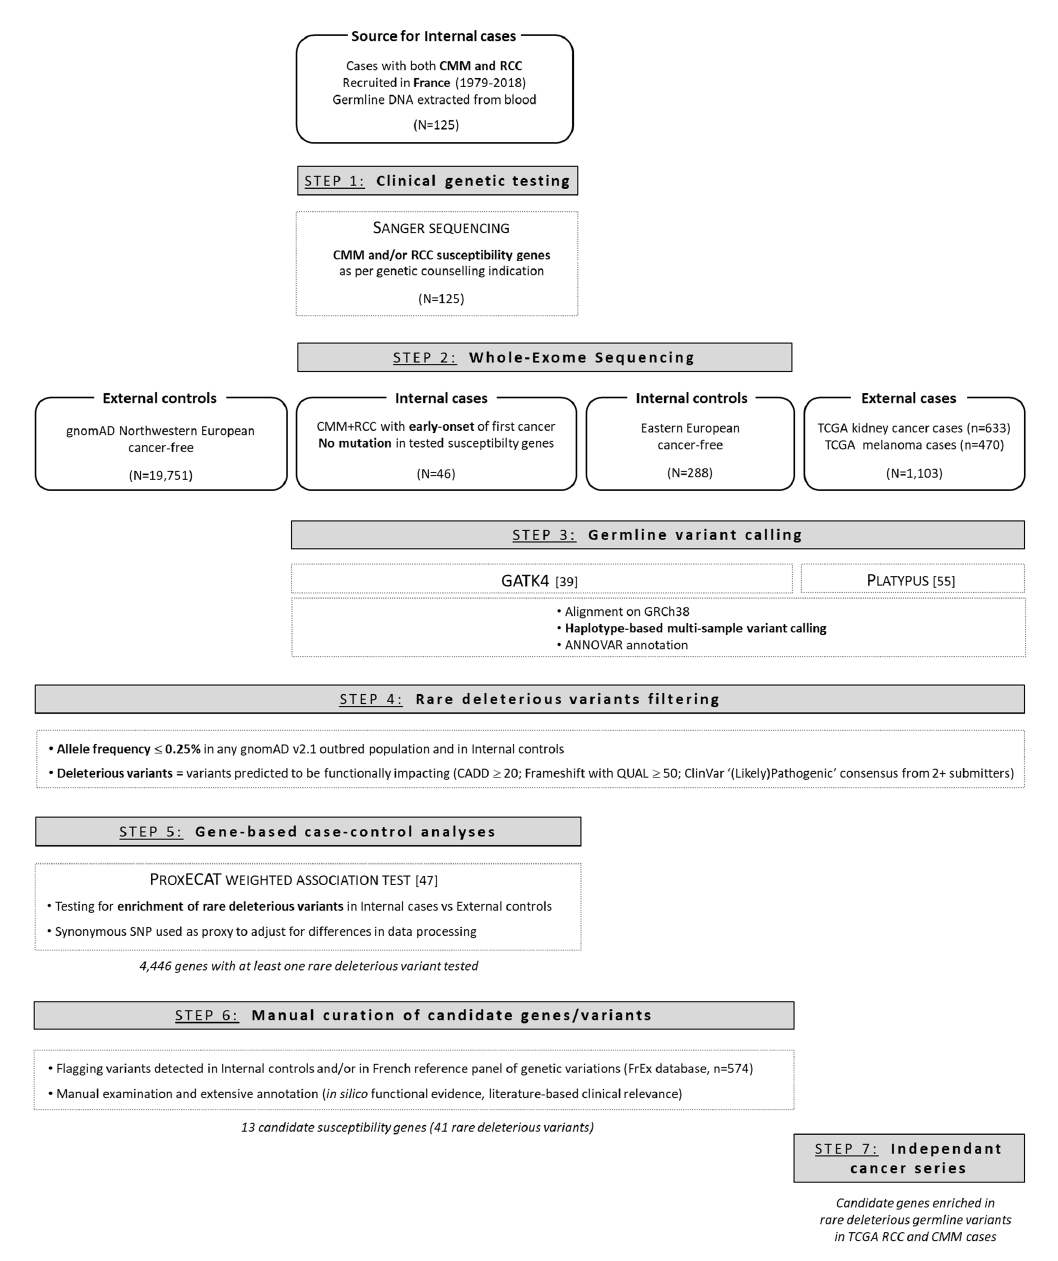
Figure 1. Flow chart of our candidate susceptibility genes discovery approach. A total of 4446 genes that displayed at least one variant matching our rarity and del- eteriousness criteria were tested. Given the distribution of gene-based q -values (Supple- mentary Table 2 and Supplemental Information), further analyses were restricted to genes displaying a q -value of 0.2 or less. A total of 13 genes displayed a significant enrichment in rare deleterious variants in cases compared to controls, namely PIK3CD , MTOR , RAE1 , ZBTB21 , ESAM , TMEM192 , CLTCL1 , NFRKB , EP300 , MTSS2 , SETD2 , SMC2, and EBF4 (Table 3, Supplemental Information). Most candidate genes showed strong evolutionary